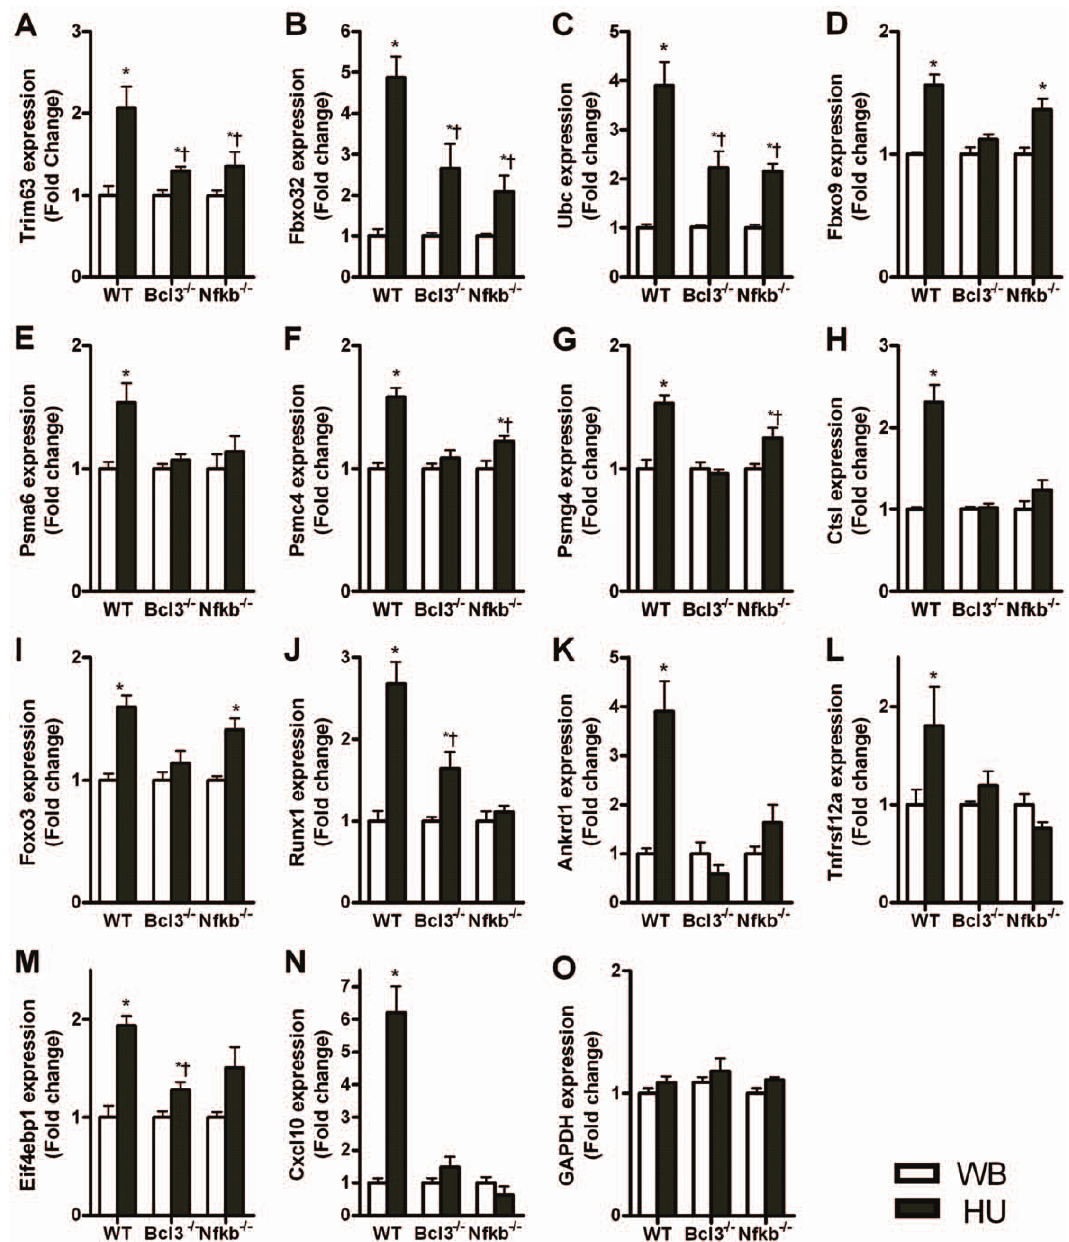
Figure 1. Quantitative real time PCR (qPCR) to measure mRNA expression of selected atrophy genes. Taqman probe and primer sets were used to confirm mRNA expression from microarray data of gastrocnemius and plantaris muscles. All 14 genes measured confirmed a significant upregulation due to 6 days unloading (HU) compared to weight bearing (WB) in muscles of wild type (WT) mice. Gene expression due to unloading in knockout mice ( Nfkb1 and Bcl-3 ) was either not different from weight bearing or it had a significantly less increase for all cases except Fbxo9 and Foxo3 in Nfkb1 2 / 2 mice. Gene expression was measured for: A ) Trim63 (MuRF1), B ) Fbxo32 (MAFbx), C ) ubiquitin C, D ) Fbxo9, E ) Psma6, F ) Psmc4, G ) Psmg4, H ) Ctsl, I ) Foxo3, J ) Runx1, K ) Ankrd1 (Carp), L ) Tnfrsf12a (Tweak receptor), M ) Eif4ebp1, N ) Cxcl10 (IP-10), and O ) GAPDH. *significantly different from weight bearing value ( P , 0.05), { significantly different from wild type unloaded value ( P , 0.05).